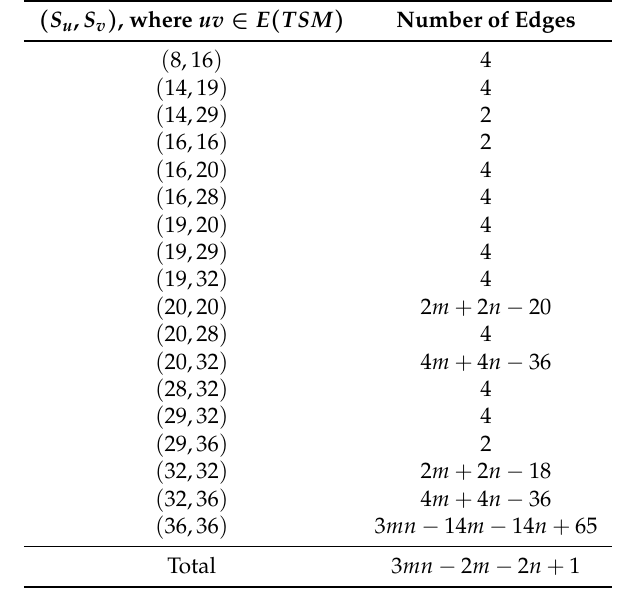
Table 3. The edge partition of the graph TSM sheet based on the degree sum of neighbor vertices of the end vertices of each edge.